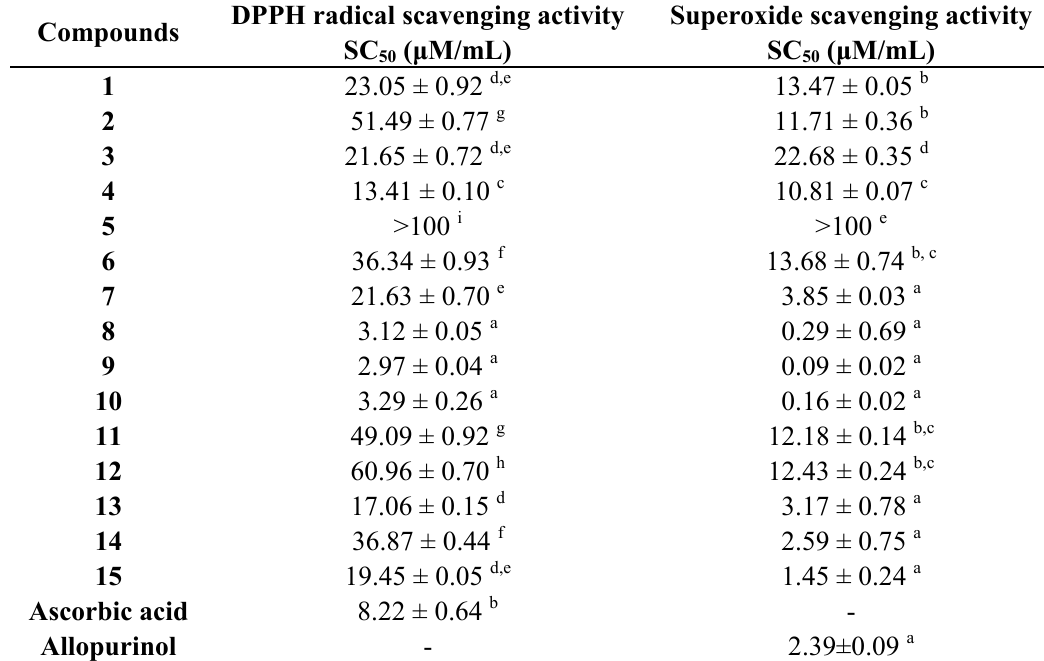
Table 2. DPPH radical scavenging and superoxide scavenging activities of each compounds 1 – 15 from CL.